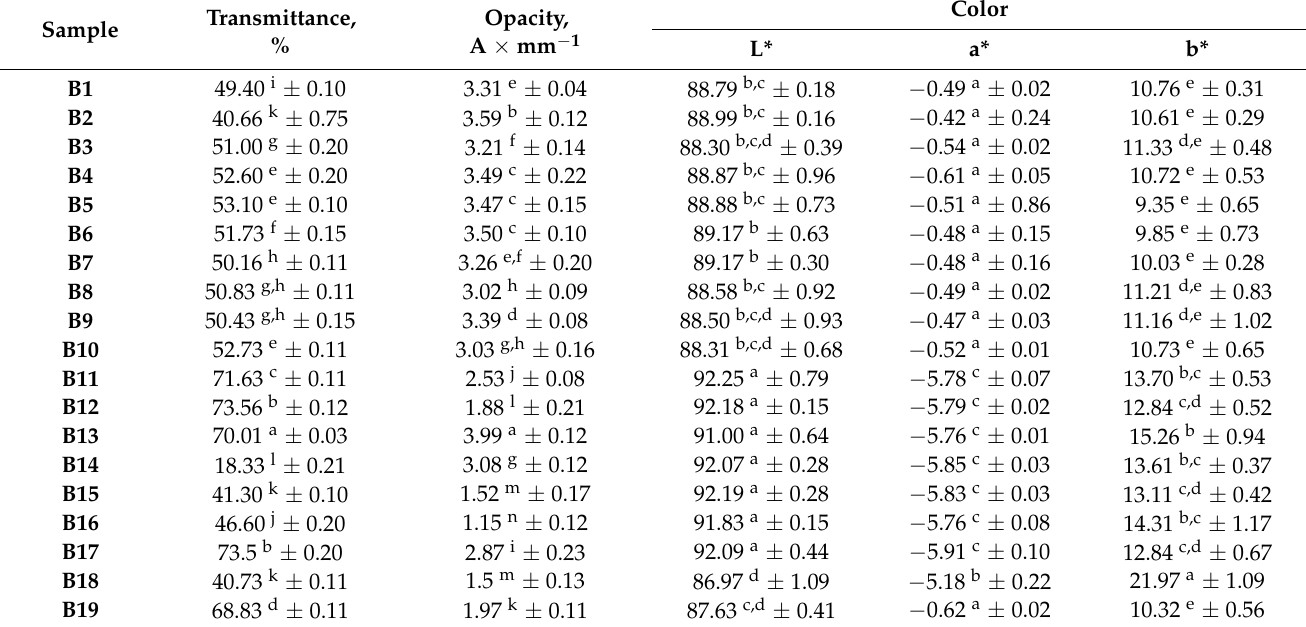
Table 4. Optical properties of films with essential oils